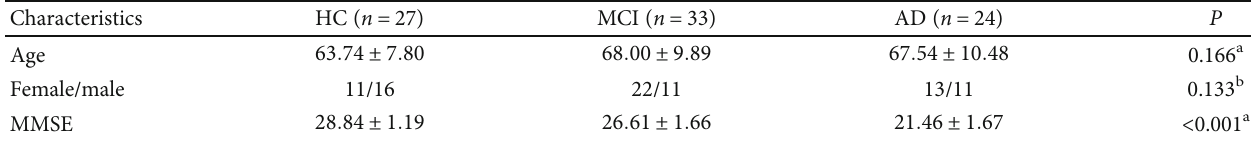
Table 1: Demographics and clinical